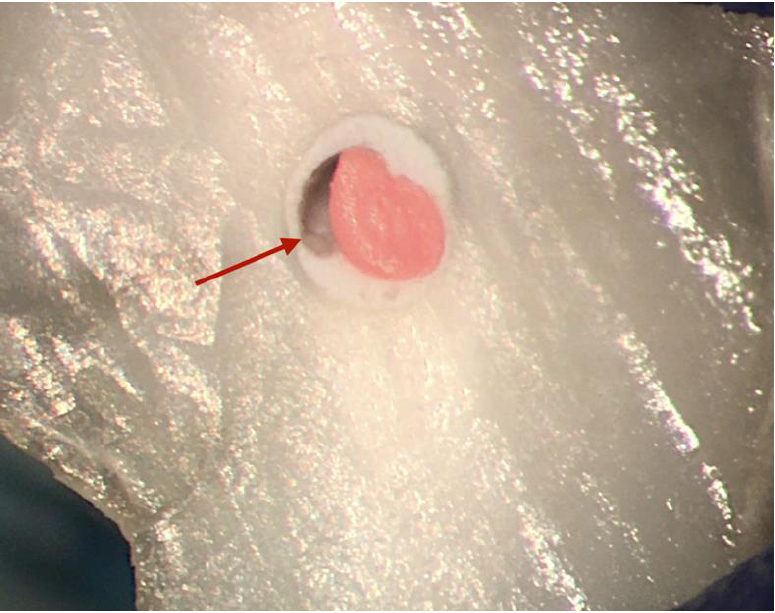
Figure 3. Large void following root canal obturation with single cone